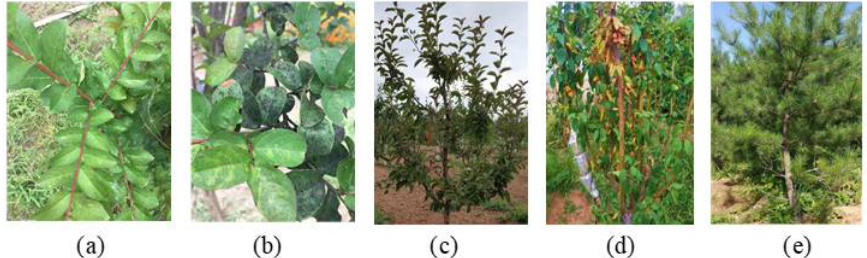
Figure 2. ( a ) Lagerstroemia indica L. growing healthily; ( b ) Lagerstroemia indica L. artificially infested